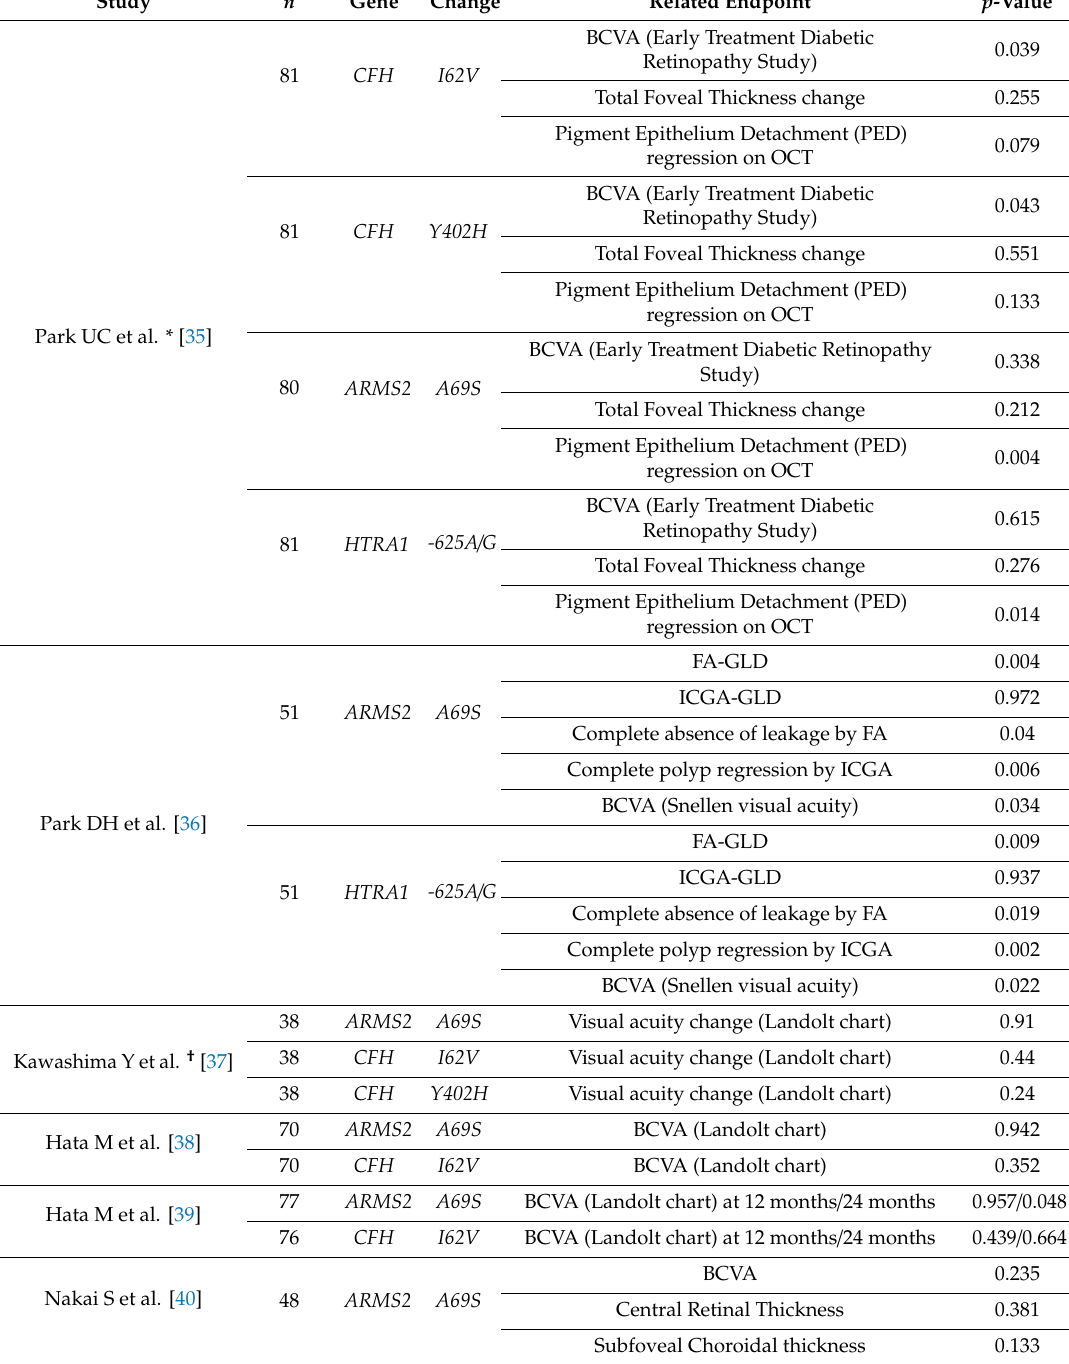
Table 3. Genetic variants and related endpoints of included